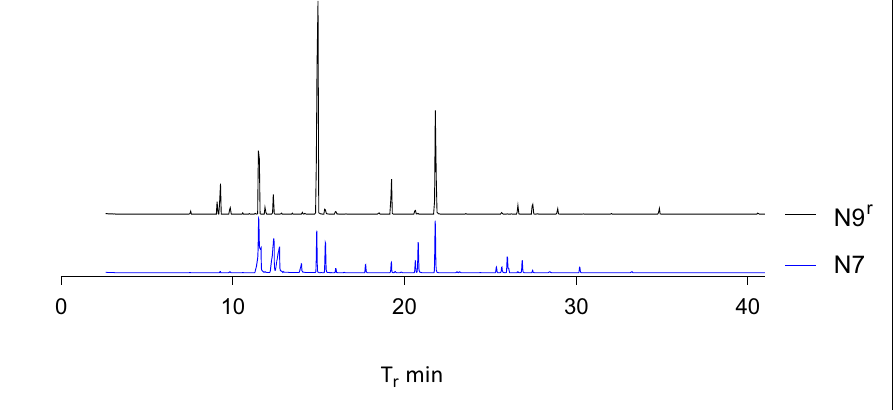
Figure 3. Sample comparison of two neroli samples as seen on